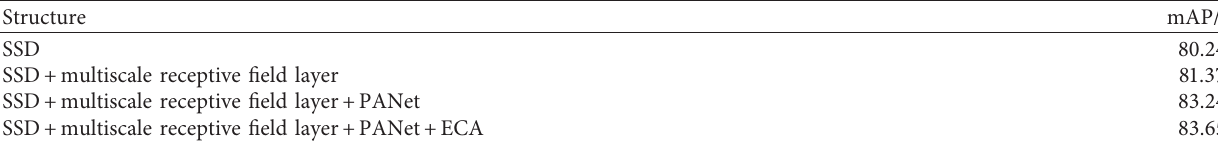
Table 2: Ablation study: mAPs of different modules.